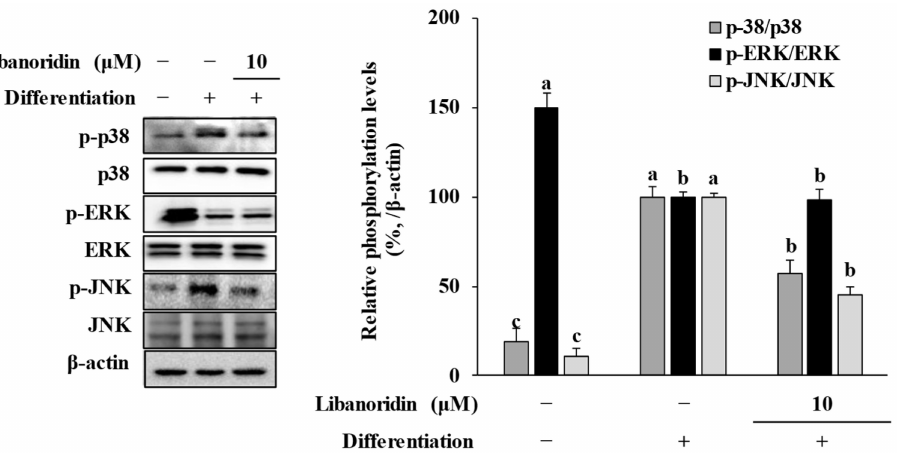
Figure 5. Effect of libanoridin on the activation of MAPKs. The total and phosphorylated (p-) levels of p38, ERK, and JNK MAPKs were investigated in adipo-induced hBM-MSCs at day 12 of differentiation by Western blot. β -actin was used as an internal loading control. Values are means ± SD ( n = 3). a–c Bars with identical letters indicate no statistical significance ( p < 0.05), while different letters indicate